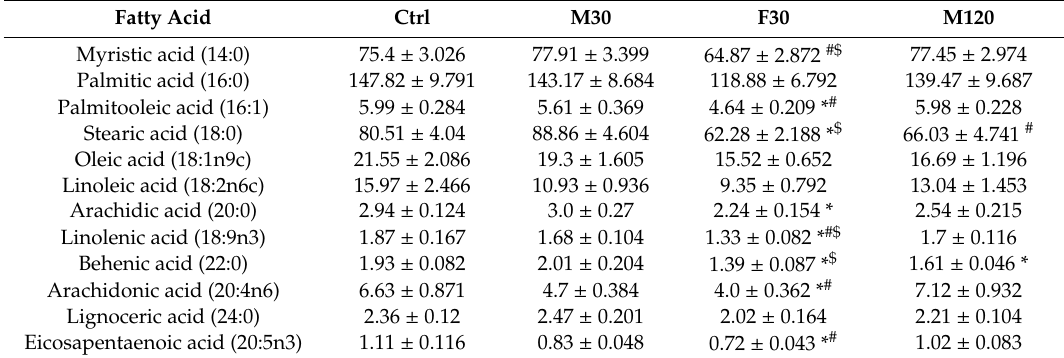
Table A4. The right ventricle FFA—fatty acid composition (nmol / g of wet